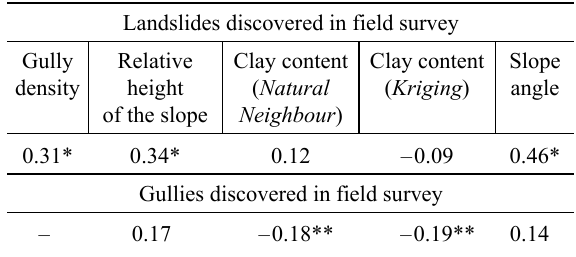
Fig. 6. Division of the study area into four zones of conditional initial (left bank side) and contemporary (right bank side) relief rasters (processed from Jarvis et al. 2008).